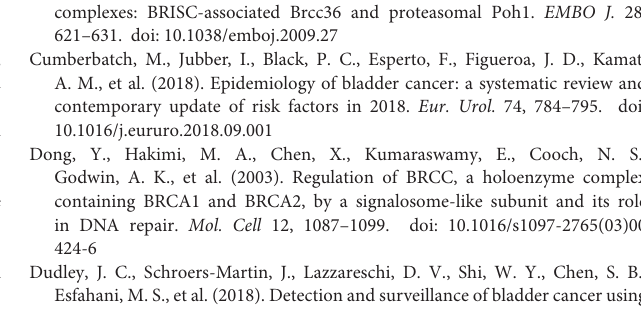
Supplementary Figure 1 | BRCC3 promotes the transcriptional activity of NF- κ B. T24 or EJ cells were transfected with an NF- κ B reporter firefly luciferase plasmid (200 ng), pRL-TK (10 ng) and the indicated amounts of a BRCC3 plasmid. Reporter assays were performed 48 h after transfection, and the results are presented as the NF- κ B/TK luciferase activity. Data were analyzed employing one-way ANOVA and presented as the means ± standard error ( n =